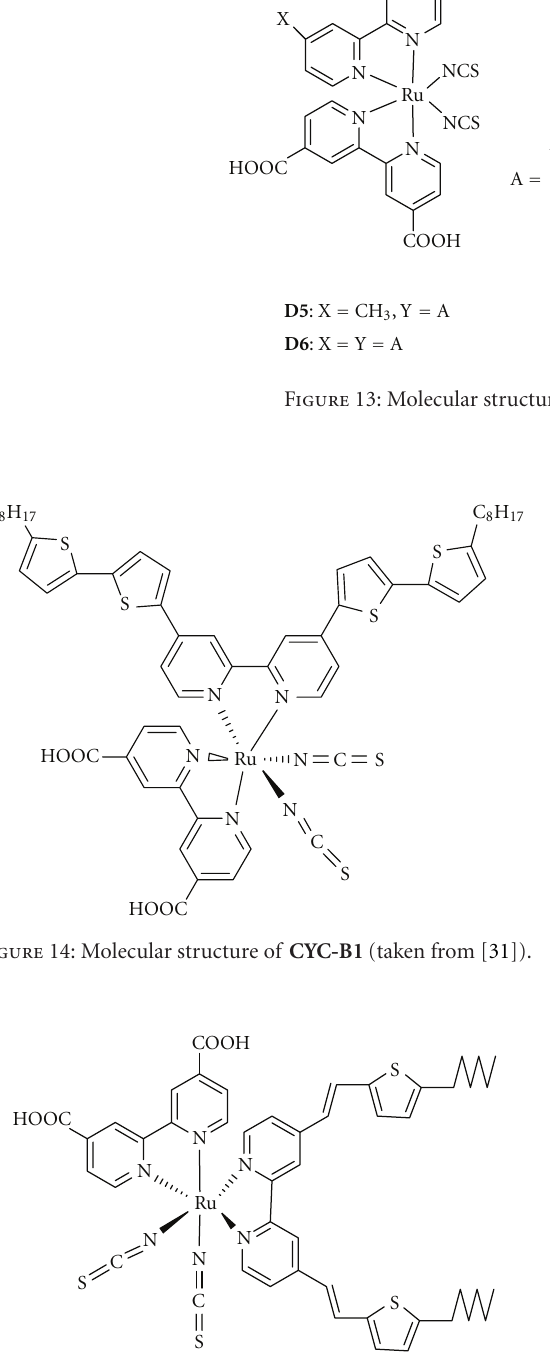
Figure 15: Molecular structure of the new sensitizer, HRS-1 (taken from